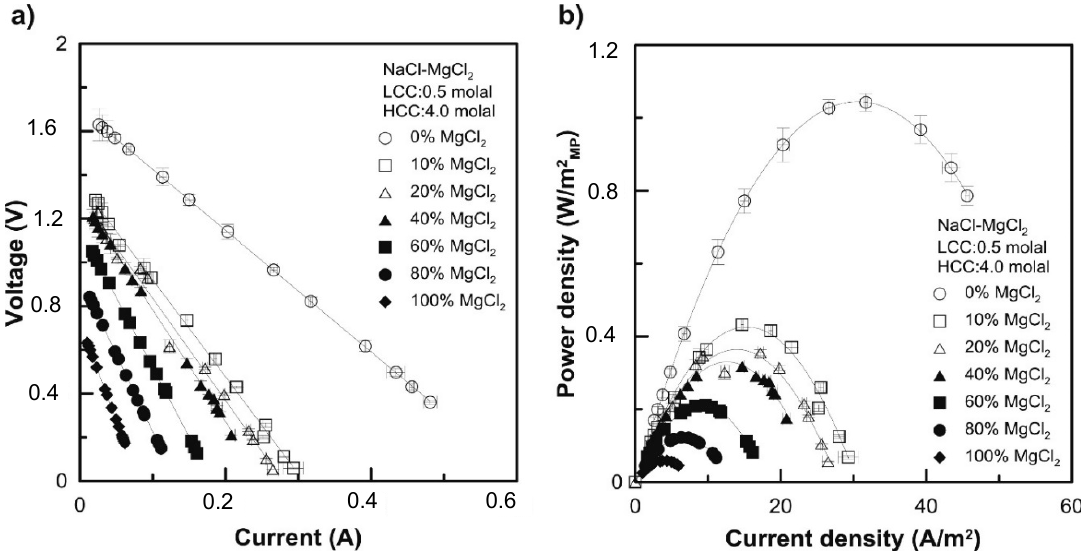
Figure 6. ( a ) Polarization curves (Voltage (V) vs. current (I)) and ( b ) gross power density (P d ) as a function of current density for RED tests using multivalent ions (NaCl/MgCl 2 ) of different molal compositions. In pure MgCl 2 solution, the power density and the OCV decreased by 94% and 57%, respectively, with respect to pure NaCl solution. Reproduced with permission from [5] . Copyright 2016 Elsevier.